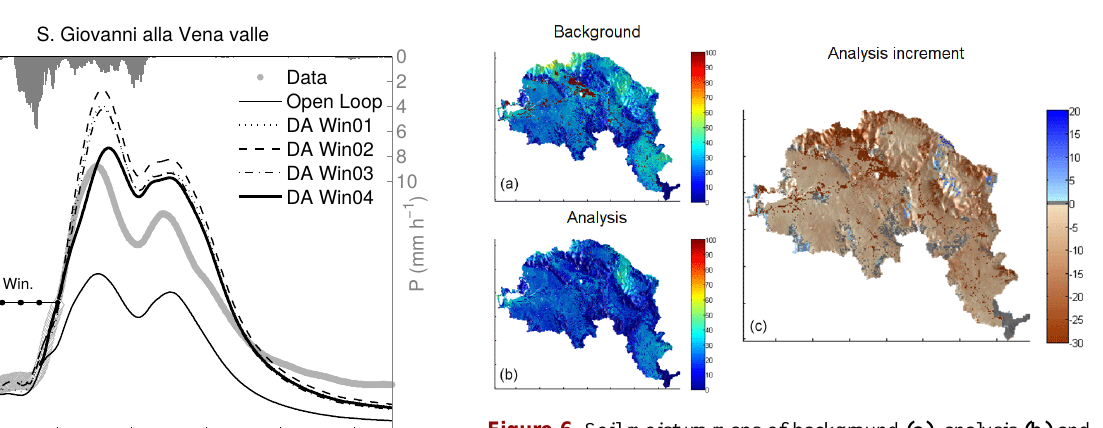
Figure 6. Soil moisture maps of background (a) , analysis (b) and increment between them (c) at the end of the assimilation window. Values are expressed as saturation level (%).